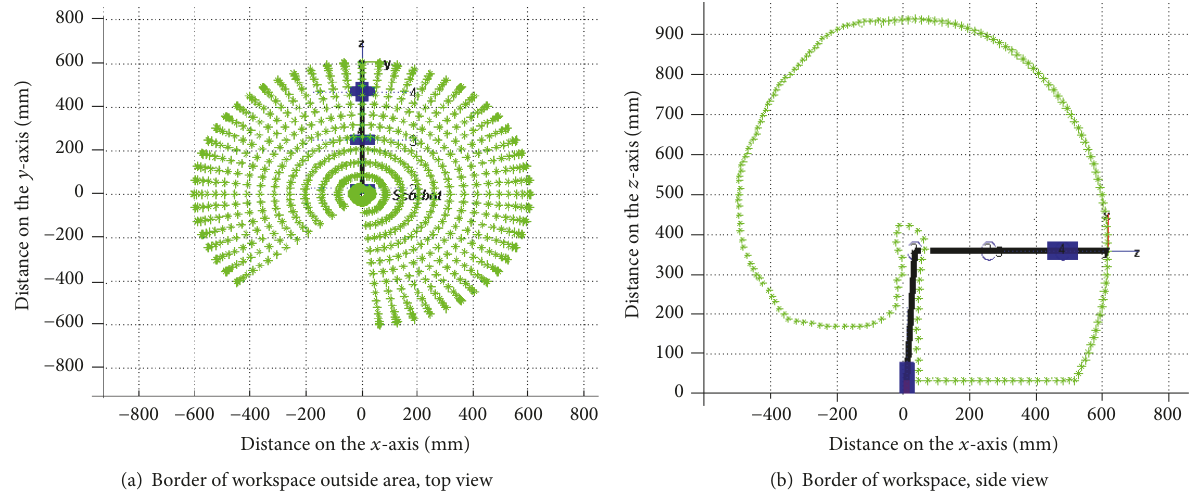
Figure 15: Scorbot workspace found in